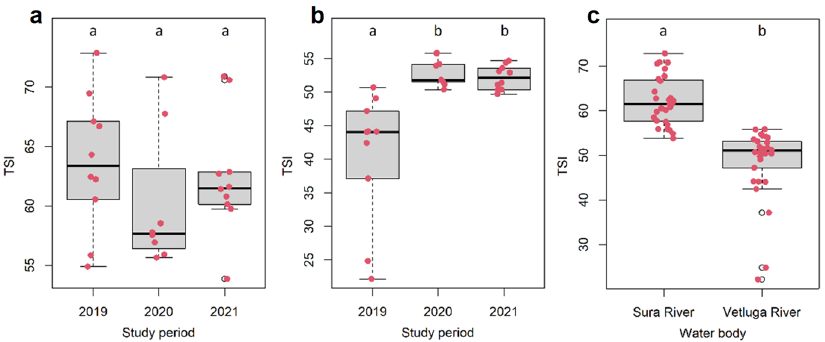
Figure 6. Boxplots of changes in the TSI in different periods (interannual variation) of the study in Sura River ( a ), Vetluga River ( b ) and in general for the entire period of the study ( c ) for mouth areas of the Sura River and the Vetluga River. Red dots—underlying distribution of the data.